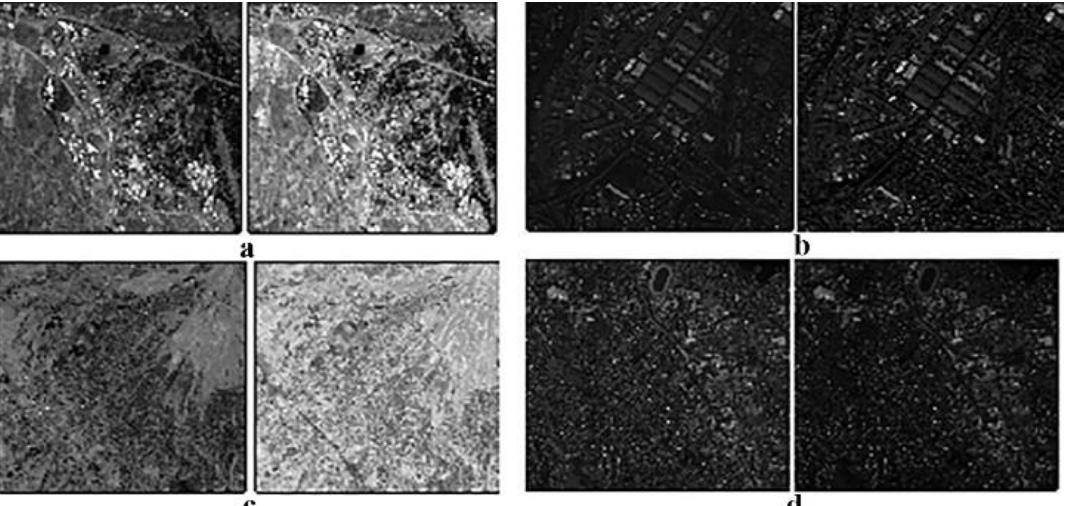
Figure 1. Input image pairs. We utilized different real images to explore the employed methods' capabilities. Case a, b, c, and d are acquired by Sentinel2, Quickbird, ETM + , and IKNOS,